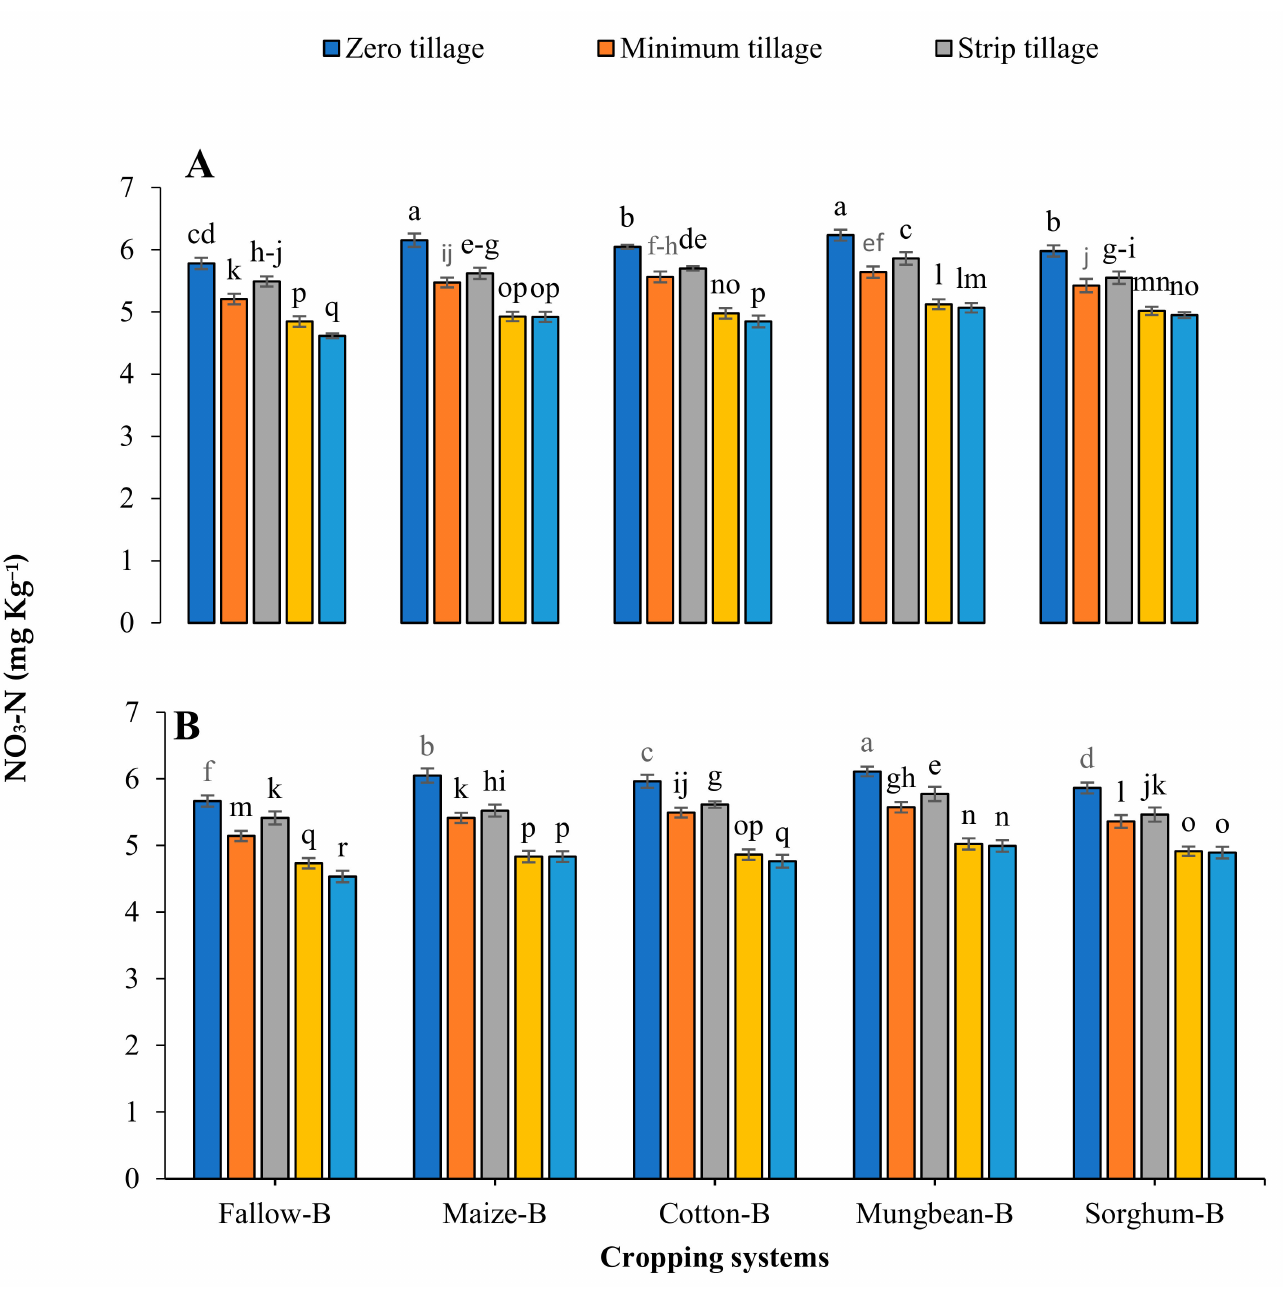
Figure 2. Interactive effect of tillage systems and barley-based cropping systems on soil NO 3 -N (mg kg − 1 ) after barley harvest during 2017–2018 ( A ) and 2018–2019 ( B ) ± S.E. In the legend, Fallow-B = Fallow-barley, Maize-B = Maize-barley, Cotton-B = Cotton-barley, Mungbean-B = Mungbean-barley and Sorghum-B = Sorghum-barley. The means sharing same letters do not differ significantly ( p > 0.05). LSD 0.05 (2017–2018 = 0.08, 2018–2019 =